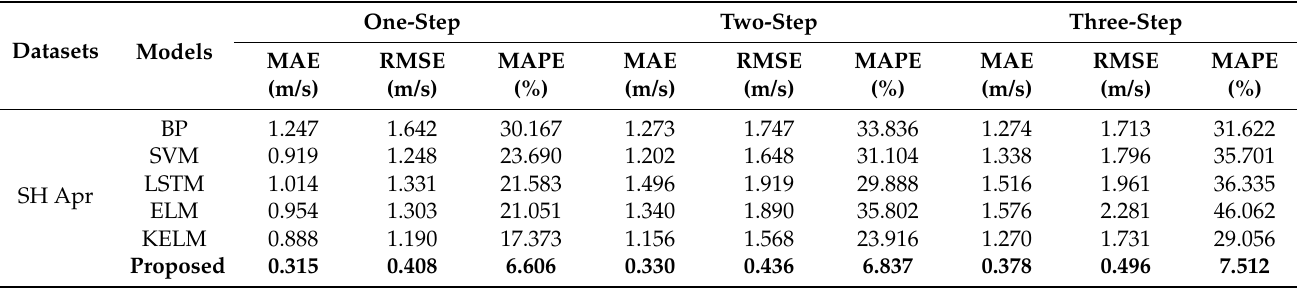
Figure 4. The results of each prediction model in three-step prediction in SH Apr. For SH Oct, according to the evaluation criteria shown in Table 3, the proposed model still outperformed the individual models in the three steps, with MAPE values of 2.367%, 2.541% and 2.844%. According to the obtained MAPE, long short-term memory (LSTM) is ranked as the second most effective model in the three forecasts, with lower MAPE values of 7.731%, 10.557% and 11.753%. For SH Jan, in all forecasting steps, the developed combined model exceeded the five benchmark models with MAPE values of 3.894%, 4.276% and 4.737%. In the two-step and three-step forecasting, the five individual models performed poorly, and their RMSE values were all over 1. Table 3. Comparison of forecasting performances of the proposed model and other independent models. BP: backpropa- gation; SVM: support vector machine; LSTM: long short-term memory; ELM: extreme learning machine; KELM: kernel extreme learning